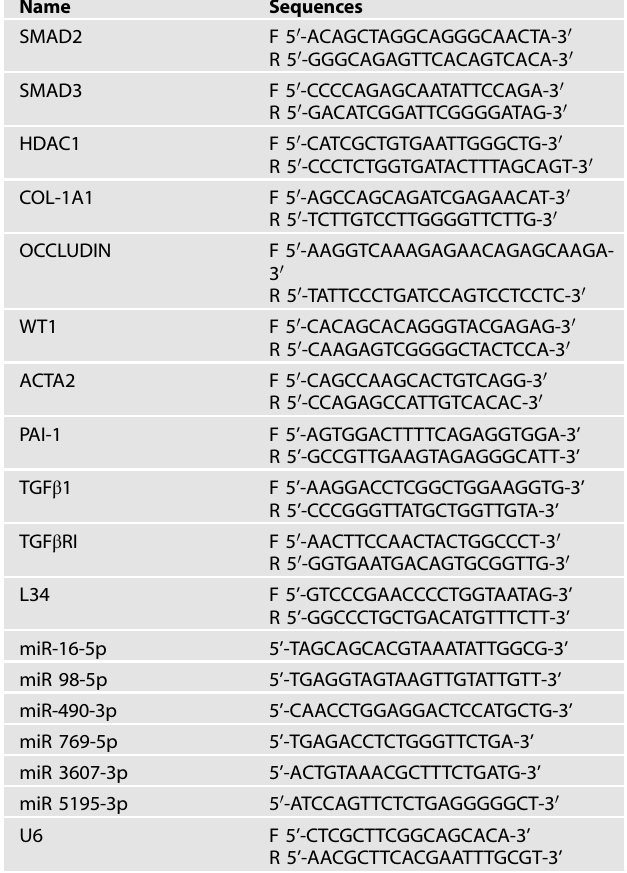
Table 2. List of PCR primers used in this